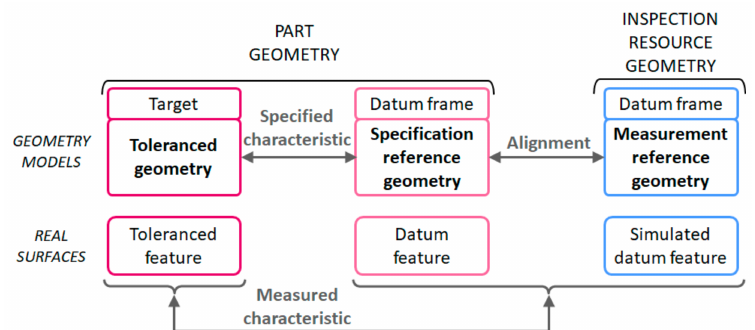
Figure 7. Geometries involved in